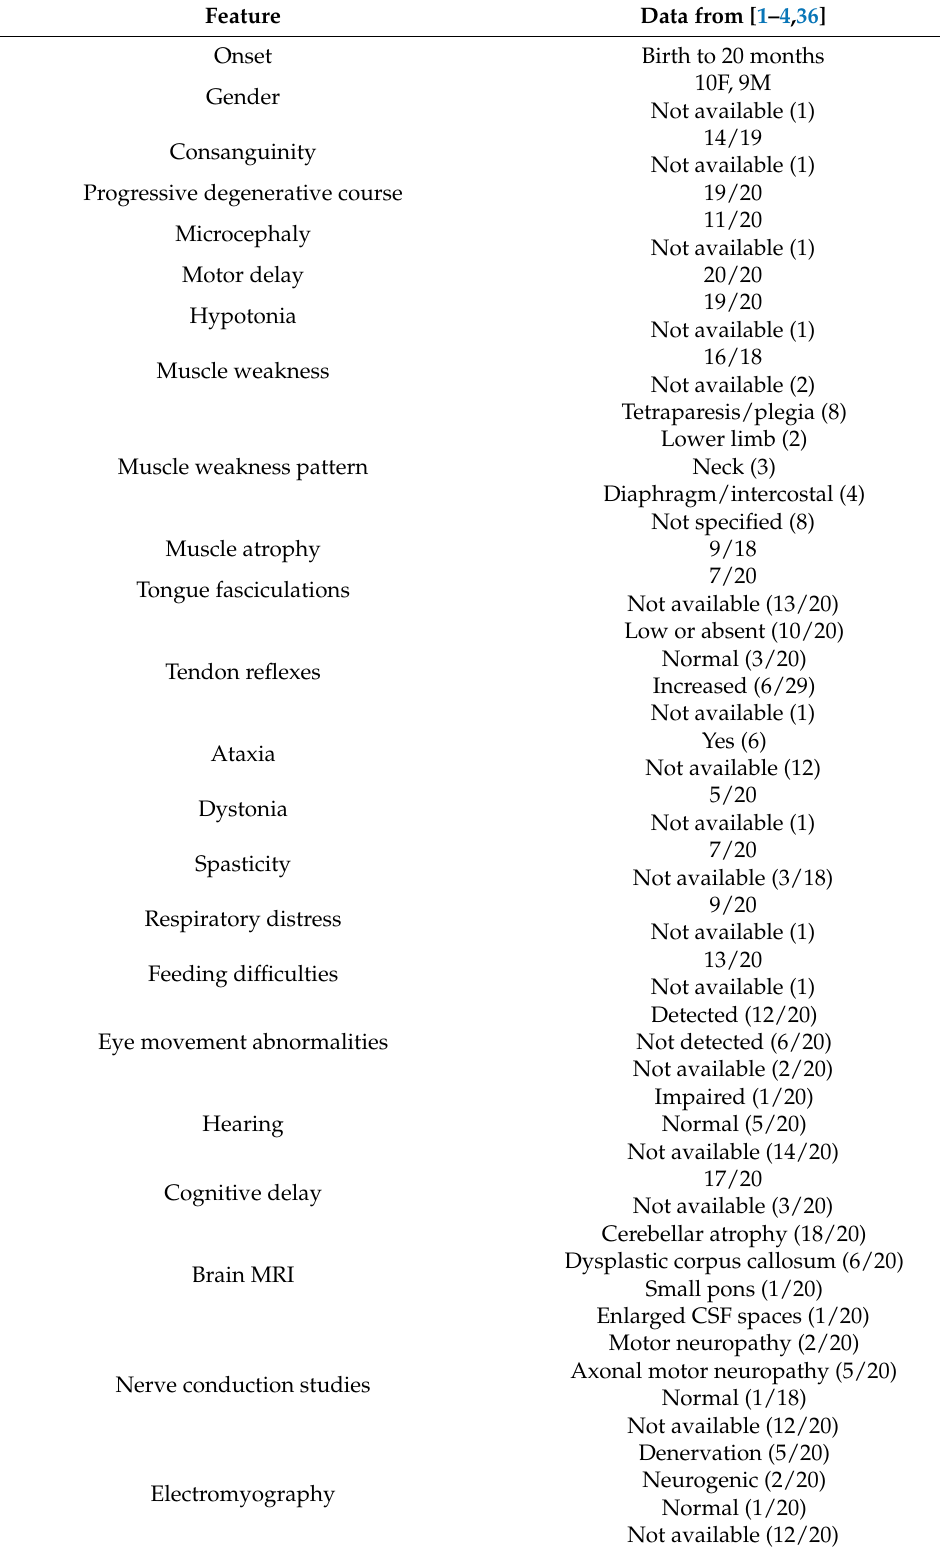
Table 2. Clinical findings reported for patients harboring AGTPBP1 -mutated